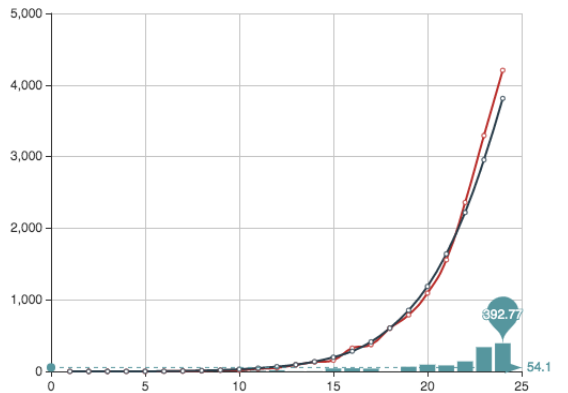
Figure 4. Representation of function E consisting of cumulative recovered individuals plus the dead (black line) and its Monte Carlo approximation (red line). The bar graph is the pointwise error with the maximum (red point) and the average (dashed